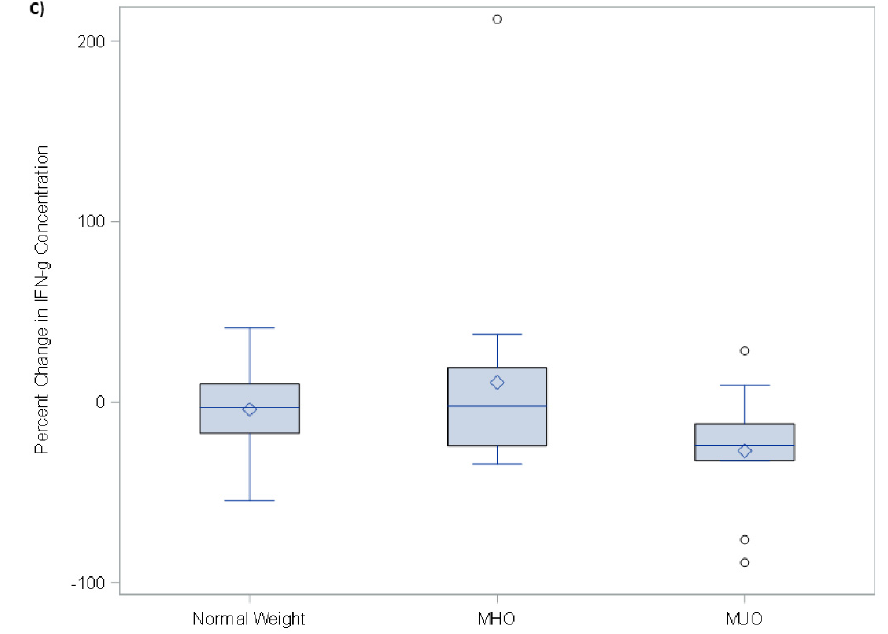
Figure 4. ( A – C ) Adiponectin, GM-CSF, and IFN-g percent change from baseline to 1 month post- influenza vaccination.